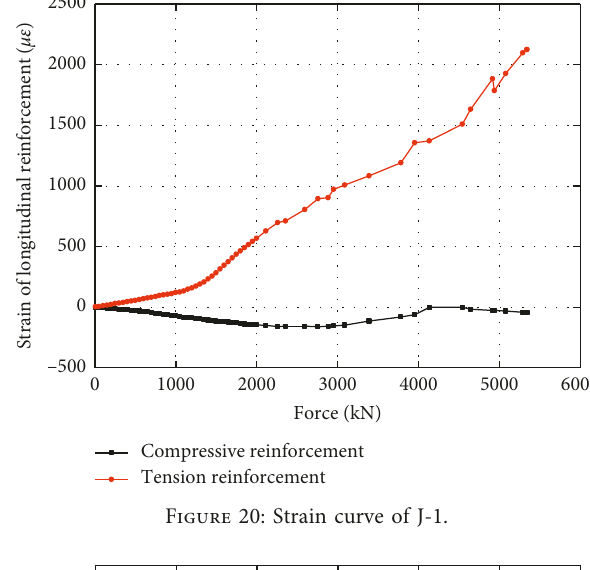
Figure 18: Stirrup strain curve of J-3.